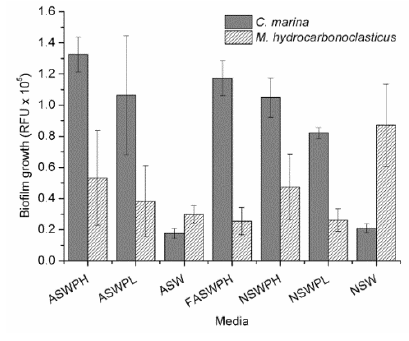
Figure 2. Biofilm formation after 24 h for both species, M. hydrocarbonoclasticus